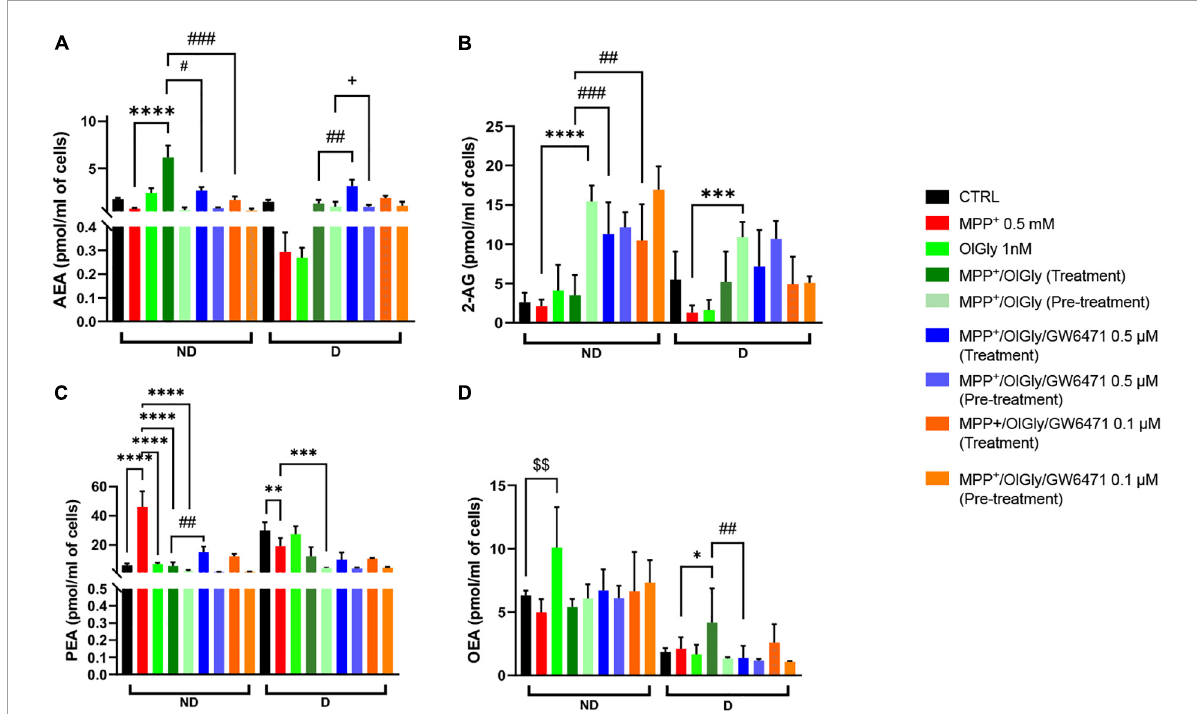
FIGURE7 Levels of endocannabinoids (eCBs) and related N -acylethanolamines is not differentiated and differentiated SH-SY5Y cells. (A) Levels of anandamide (AEA) expressed as pmol/ml of cell culture medium. (B) Levels of 2-arachidonoyl glycerol (2-AG) expressed as pmol/ml of cell culture medium. (C) Levels of palmitoylethanolamide (PEA) expressed as pmol/ml of cell culture medium. (D) Levels of oleoylethanolamide (OEA) expressed as pmol/ml of cell culture medium. Data are represented as mean ± SEM. § indicates values statistically significant vs. control; ∗ indicates values statistically significant vs. MPP + ; # indicates values statistically significant vs. MPP + /OlGly (treatment). Student’s t -test was used for statistical analysis ( N = 6–9). ∗∗∗∗ Indicates values statistically significant with p < 0.0001; ∗∗∗ , ### , and +++ indicates values statistically significant with p < 0.001; ∗∗ , ### , and §§ indicates values statistically significant with p < 0.01; ∗ , # , and + indicates values statistically significant with p <